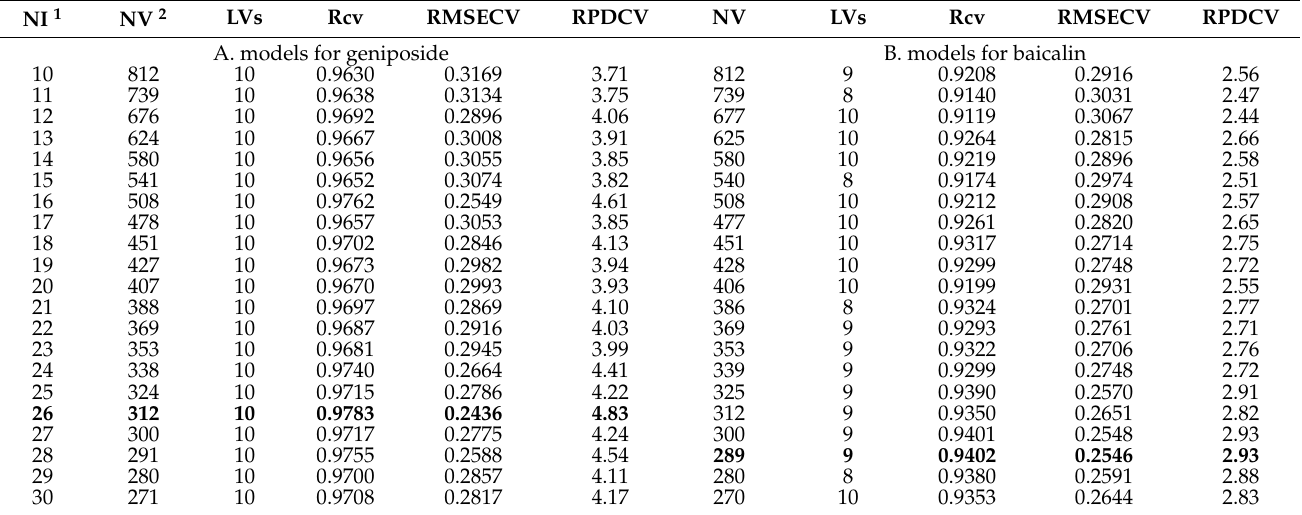
Table 3. Calibration results by SIPLS model with different spectral range